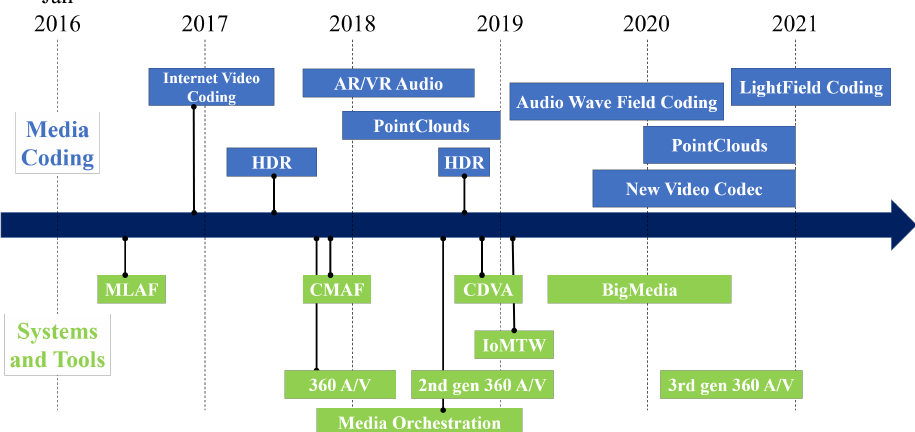
Figure 2. Moving Picture Experts Group (MPEG) standardization